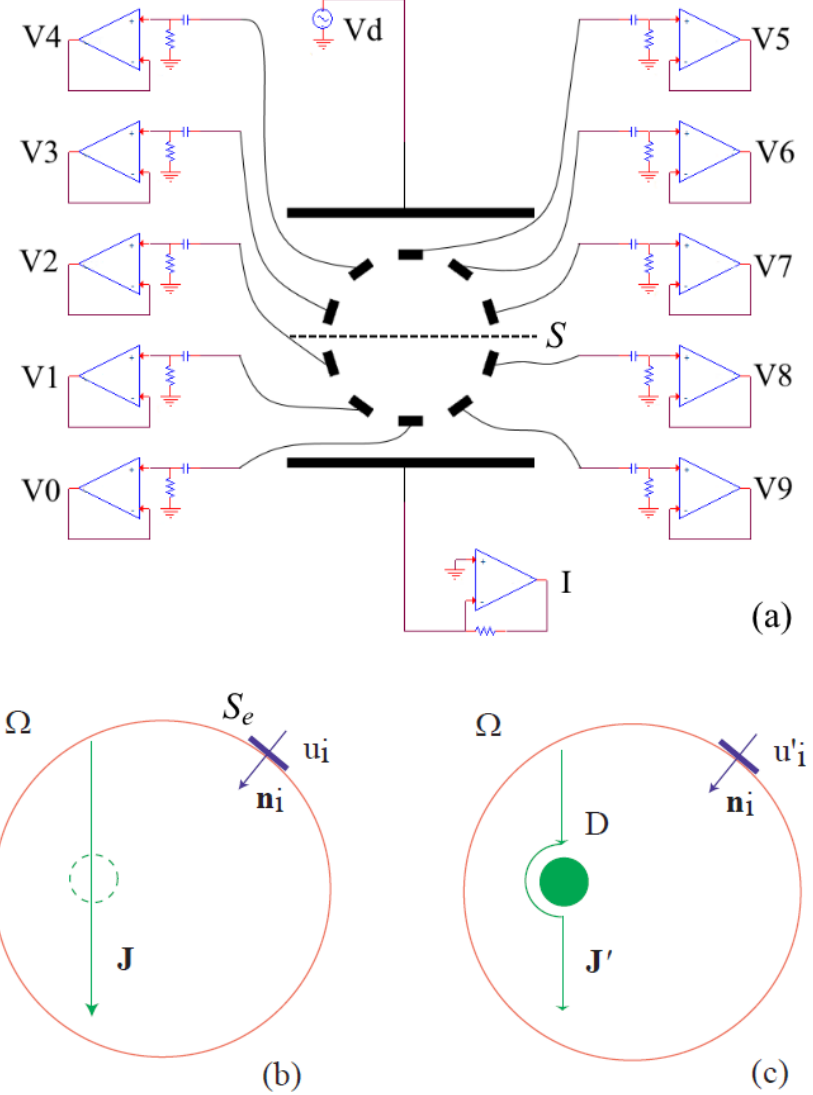
Figure 2. ( a ) Schematic of the board, where potentials V i of the sensing electrodes with i = 0, . . . ,9 are shown; moreover, the pair of outer current electrodes have applied voltage Vd and current I . ( b ) Current conduction in domain Ω without insulating domain. ( c ) Current conduction in Ω − D